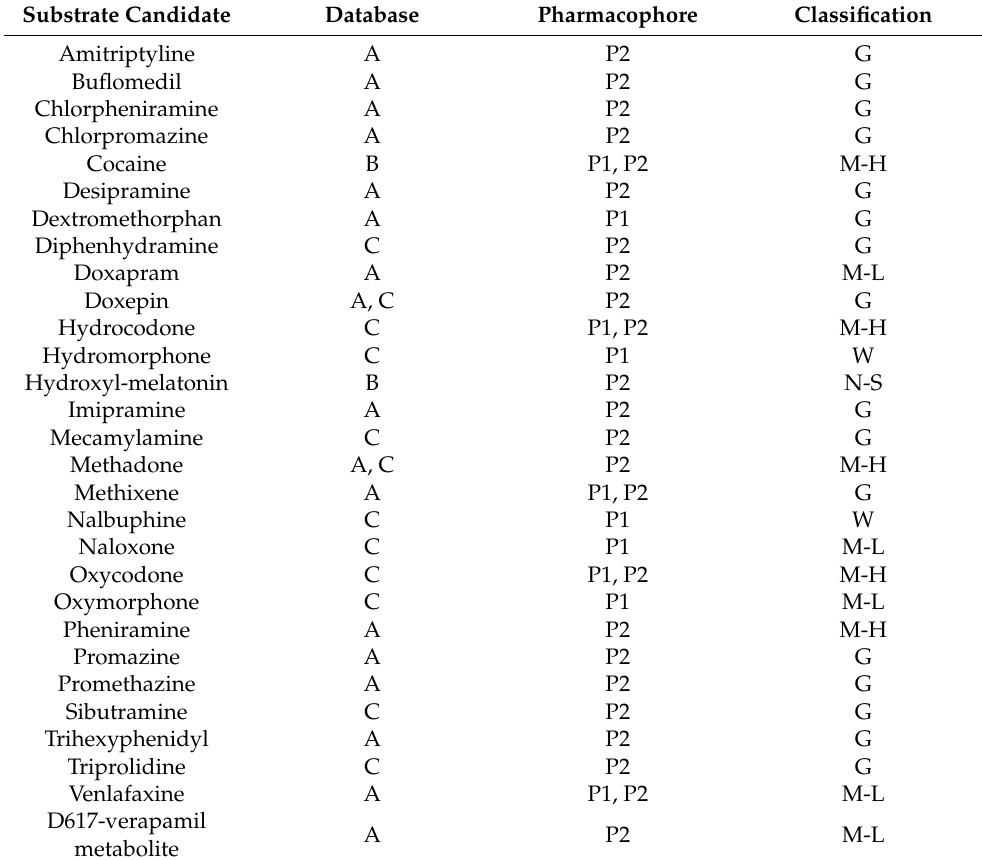
Table 4. List of substrate candidates for the proton-antiporter based on the virtual screening results of drug and natural/endogenous compound databases using either P1 or P2 as templates and in vitro substrate classification by trans-stimulation studies in hCMEC/D3